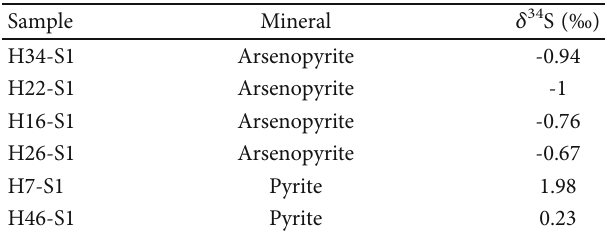
Table 7: Isotope values of δ 34 S in the arsenopyrite or pyrite of the Daping gold